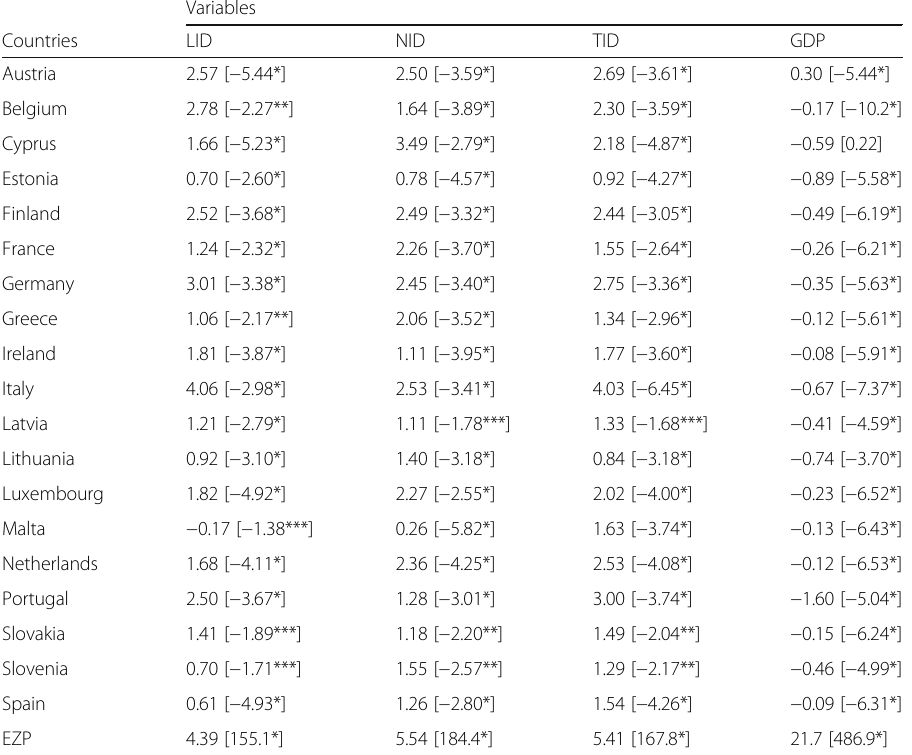
Table 2 Results of Unit Root